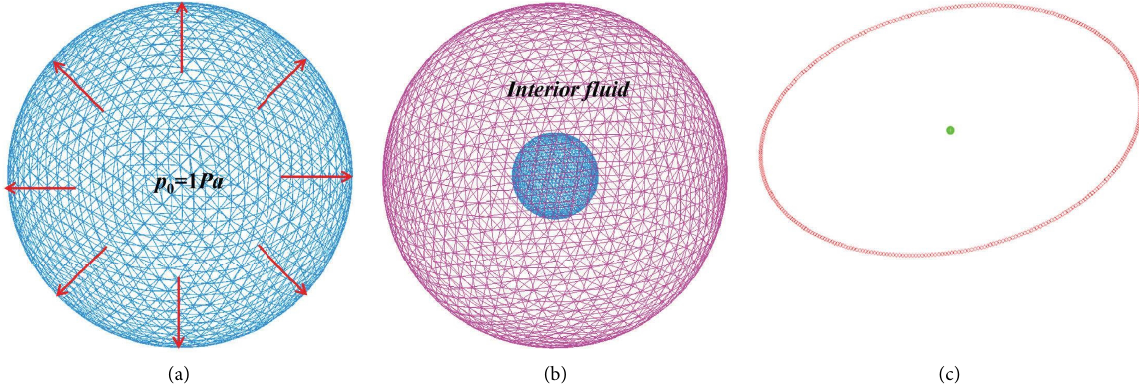
Figure 4: (a) Structural FE meshes; (b) interior fuid FE meshes; and (c) acoustic feld points.